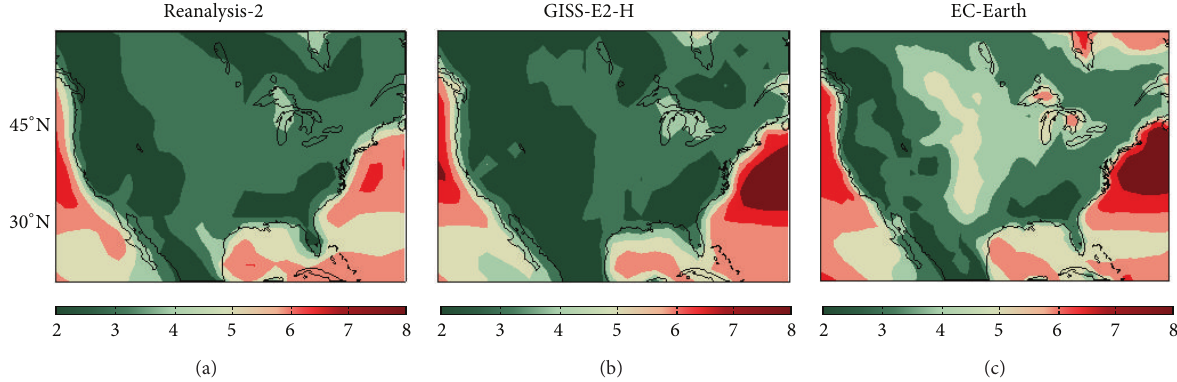
Figure 4: A comparison of the 1979–1999 climatology of the surface wind speed from NCEP-DOE reanalysis-2 (a) and the historical runs with two models (b) GISS-E2-H and (c) EC-Earth in CMIP5. The color scale, in m/s, is shown at bottom with red color indicating high wind speed.